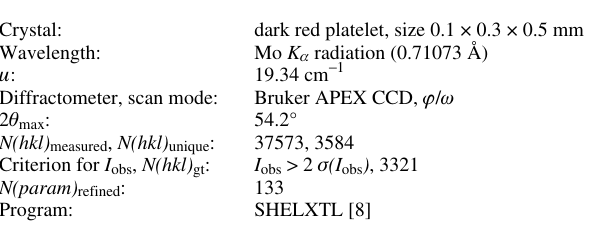
Table 1. Data collection and handling. Table 2. Continued